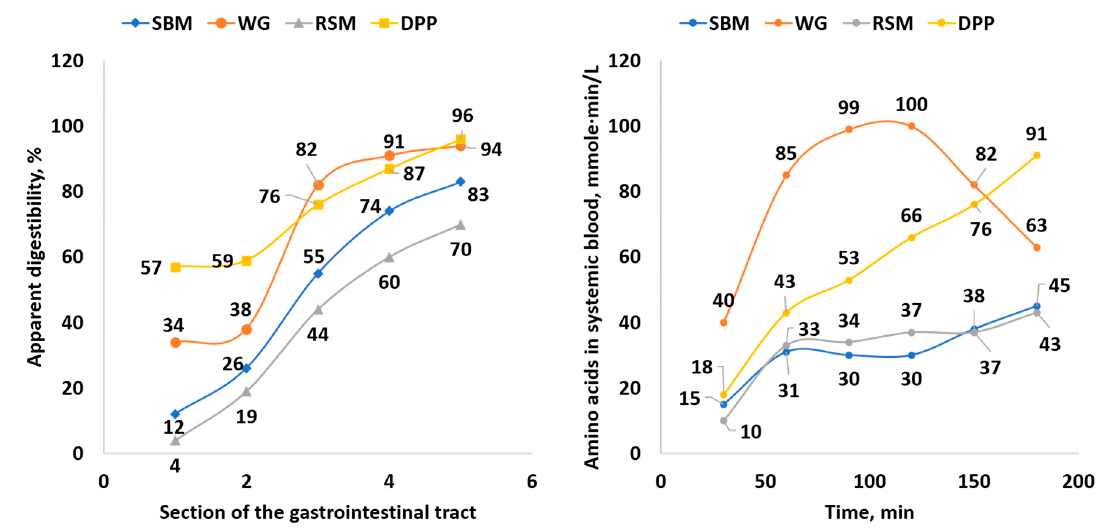
Figure 1. Apparent digestibility of crude protein along sections of the small intestine (1 – 4), total tract digestibility (5; left panel), and AA concentration in systemic blood at different time points (right panel) in pigs fed diets containing soybean meal (SBM), wheat gluten (WG), rapeseed meal (RSM), and dried porcine plasma (DPP) (adapted from [309]).